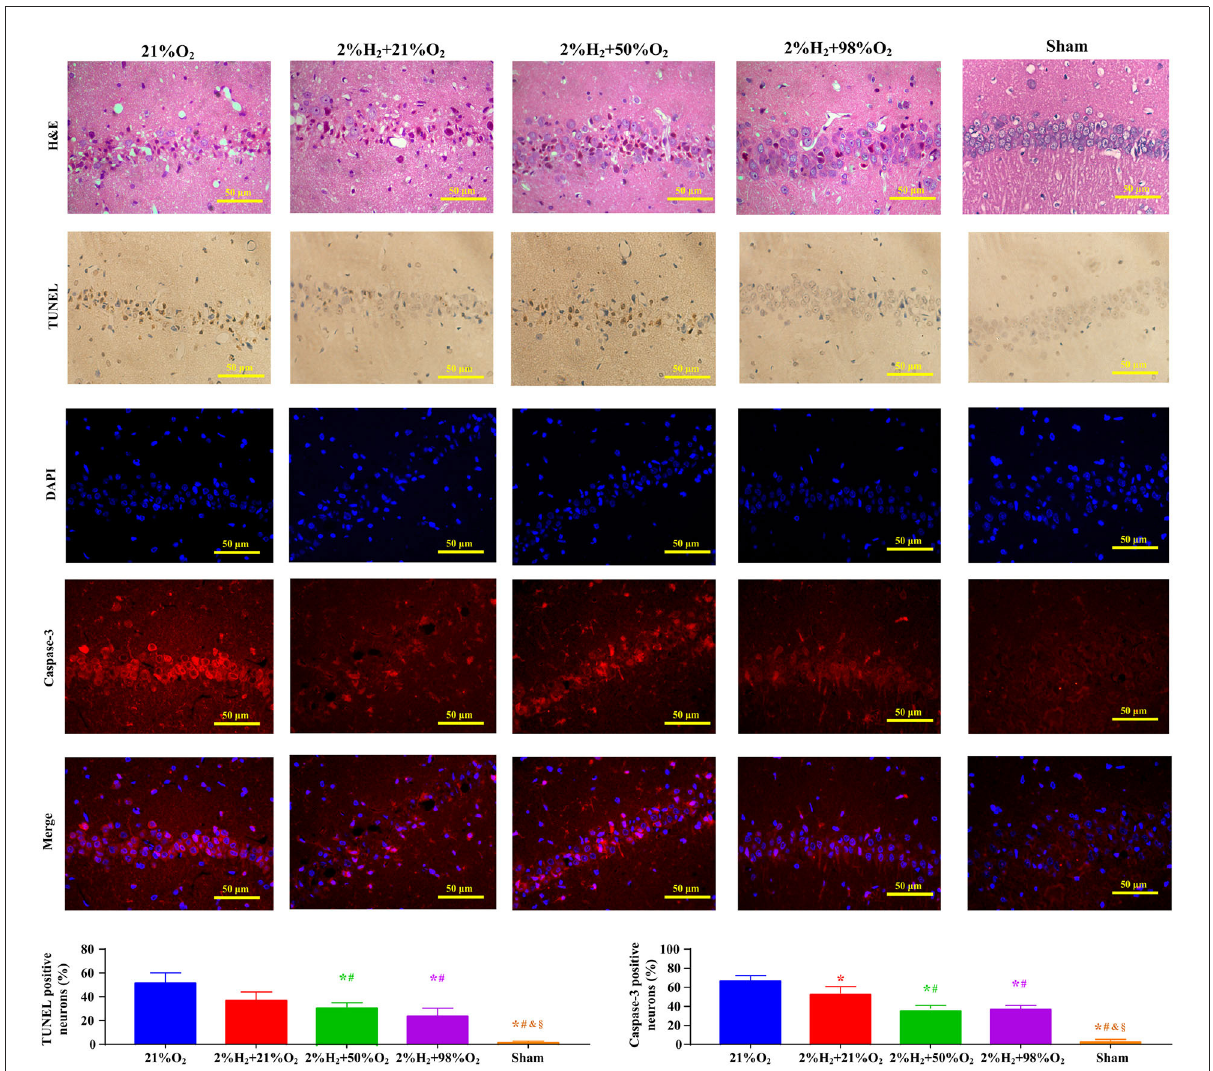
FIGURE5 Representative micrographs of the hematoxylin and eosin (H&E), terminal deoxynucleotidyl transferase-mediated deoxyuridine triphosphate nick end labeling (TUNEL), 4 ′ ,6-diamidino-2-phenylindole (DAPI), Caspase-3 stained neurons in the CA1 hippocampus region, ratio of TUNEL positive neurons, and ratio of Caspase-3 positive neurons at 96h after resuscitation in animals under hypothermia. * p < 0.05 vs. 21%O 2 group; # p < 0.05 vs. 2%H 2 + 21%O 2 group; & p < 0.05 vs. 2%H 2 + 50%O 2 group; § p < 0.05 vs. 2%H 2 + 98%O 2